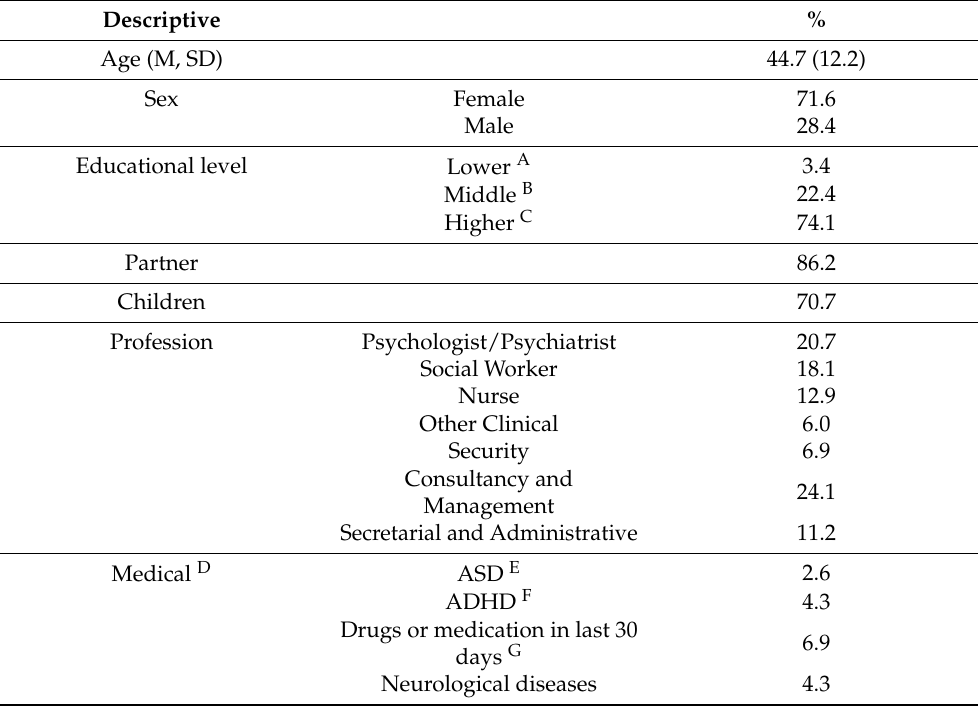
Table 1. General sample characteristics ( n =